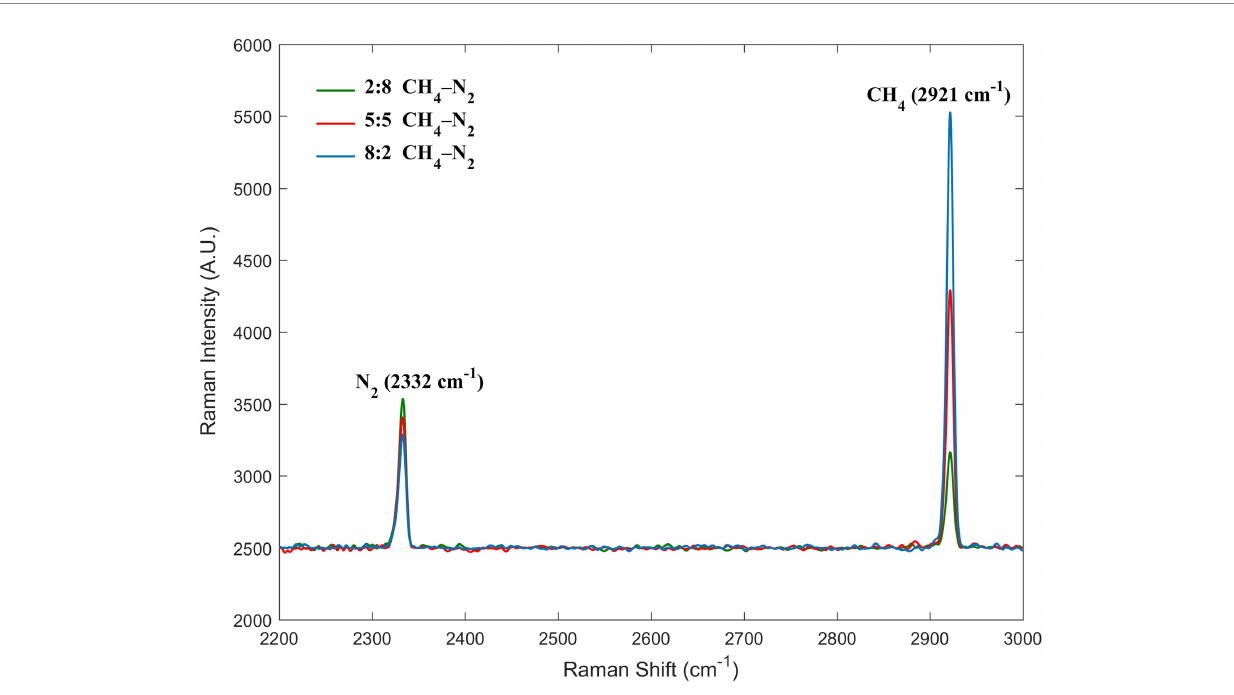
FIGURE 3 Raman spectra of three molar ratios of methane and nitrogen. The peaks at 2332 and 2,921 cm − 1 were assigned to nitrogen and methane, respectively.